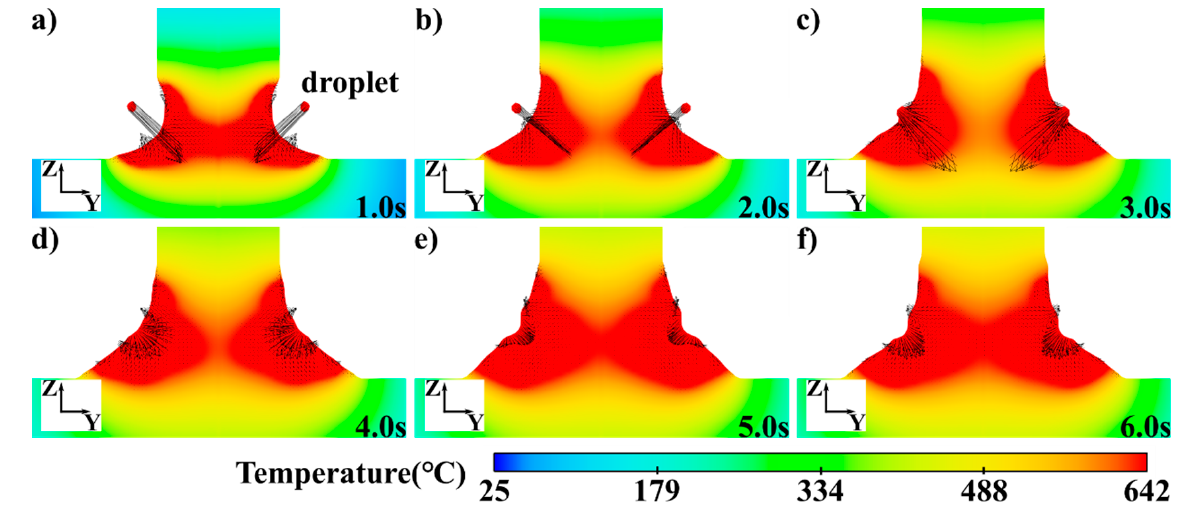
Figure 7. Transient evolution of velocity vectors on the cross section of molten pool: ( a ) 1.0 s; ( b ) 2.0 s; (c) 3.0 s; ( d ) 4.0 s; ( e ) 5.0 s; ( f ) 6.0 s.